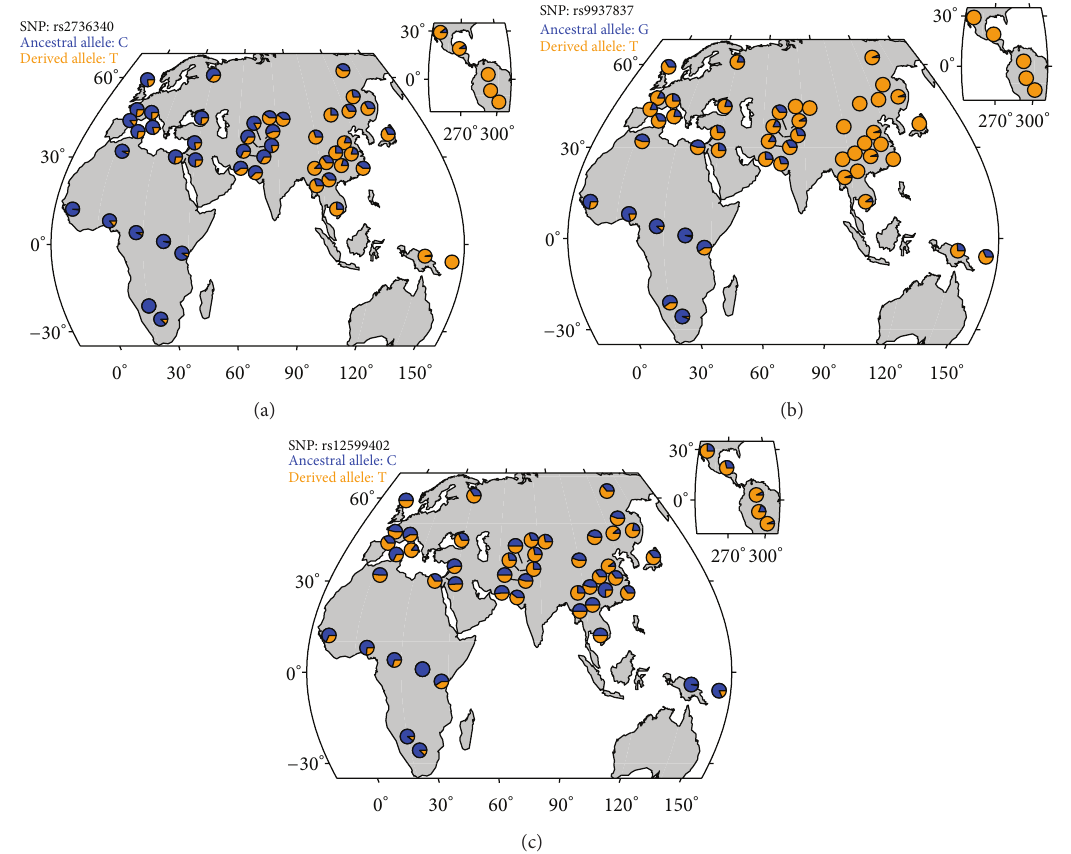
Figure 1: Worldwide distribution of allele frequencies for SLE-associated SNPs rs2736340 in BLK (a), rs9937837 in ITGAM (b), and rs12599402 in CLEC16A